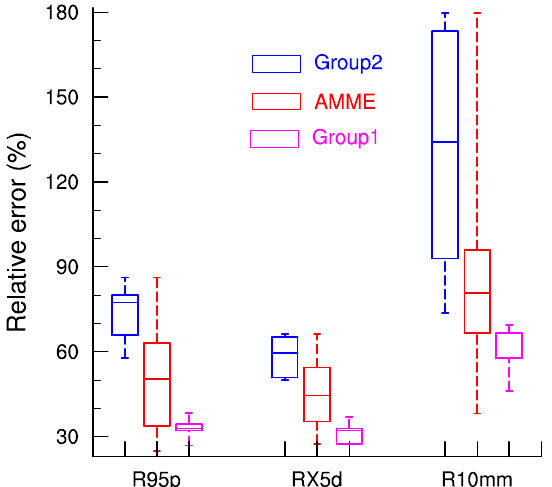
Figure 7. Box-and-whisker plot for relative error change (%) of three extreme rainfall indices including R95p, RX5d, R10mm from Group 1 (pink), AMME (red), and Group 2 (blue) over Northern China in